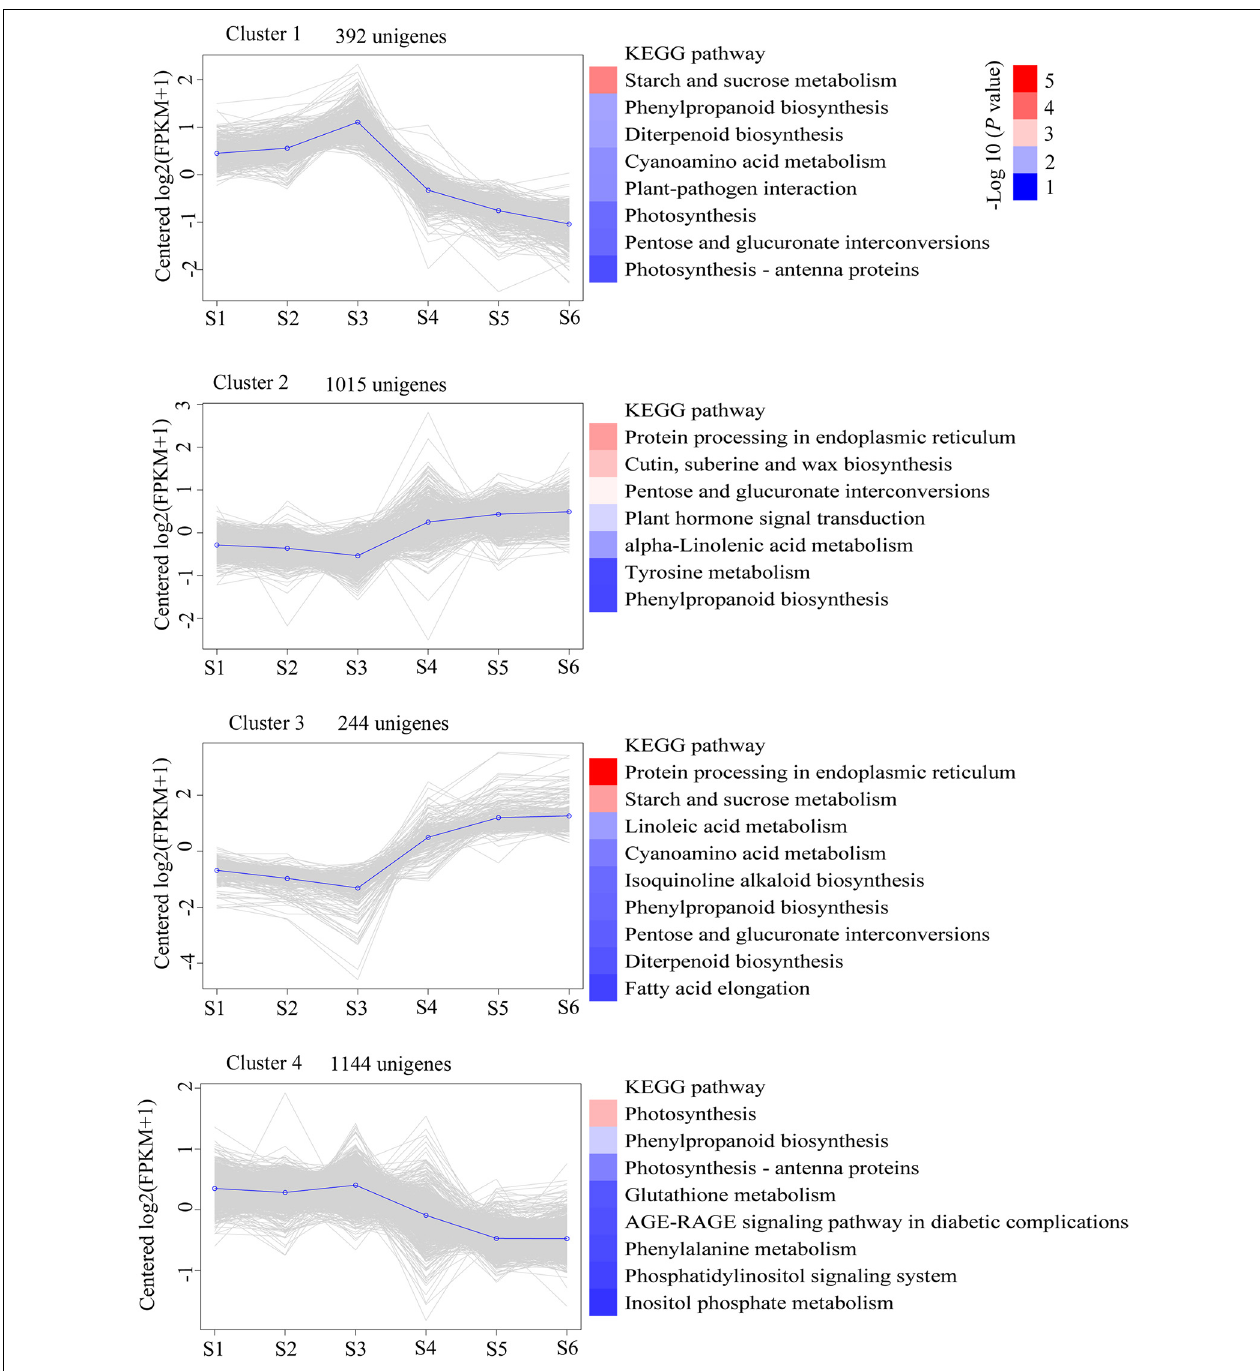
FIGURE 4 | Clustering analysis of time-course RNA-seq revealed transcriptional changes during development of the C . sinense ovule. Blue lines highlight the centroid of each cluster. The KEGG pathway categories with a P -value < 0.05 are shown. The color codes represent the -log10 ( P value).